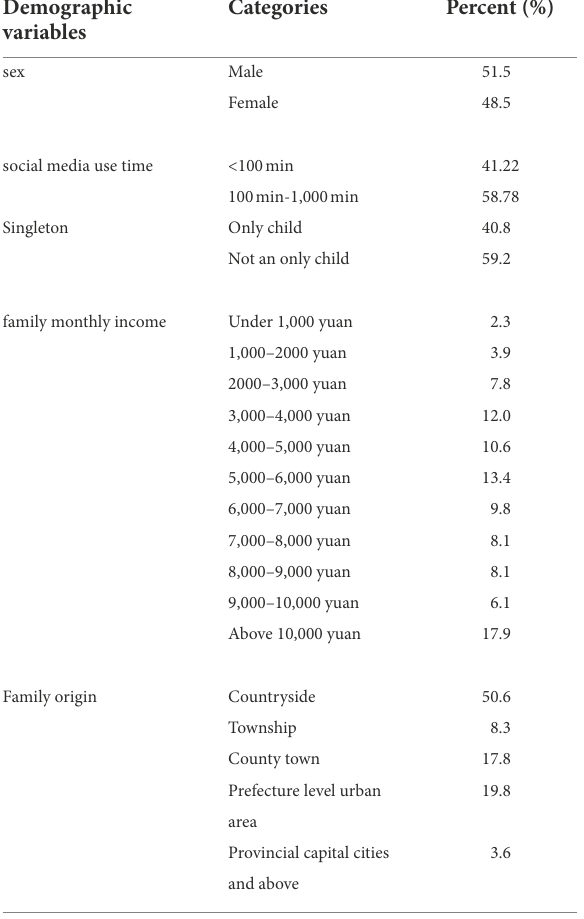
TABLE 1 Demographic